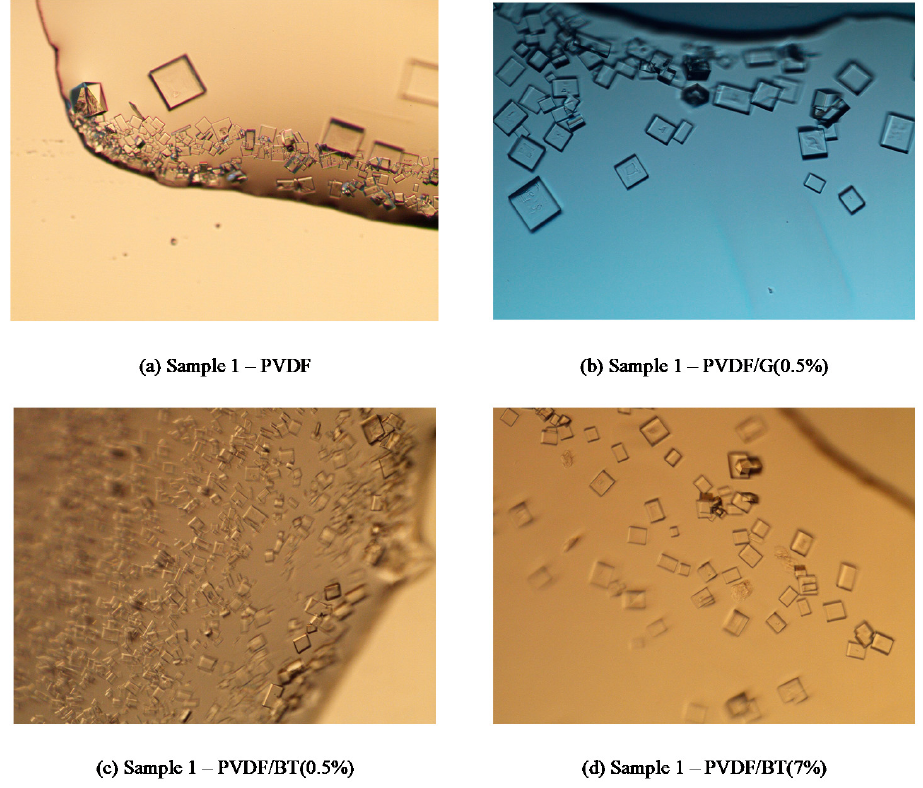
Figure 7. Pictures collected on the first sample of NaCl crystals obtained with the different analysed membranes: ( a ) PVDF, ( b ) PVDF/G (0.5%), ( c ) PVDF/BT (0.5%) and ( d ) PVDF/BT (7%).